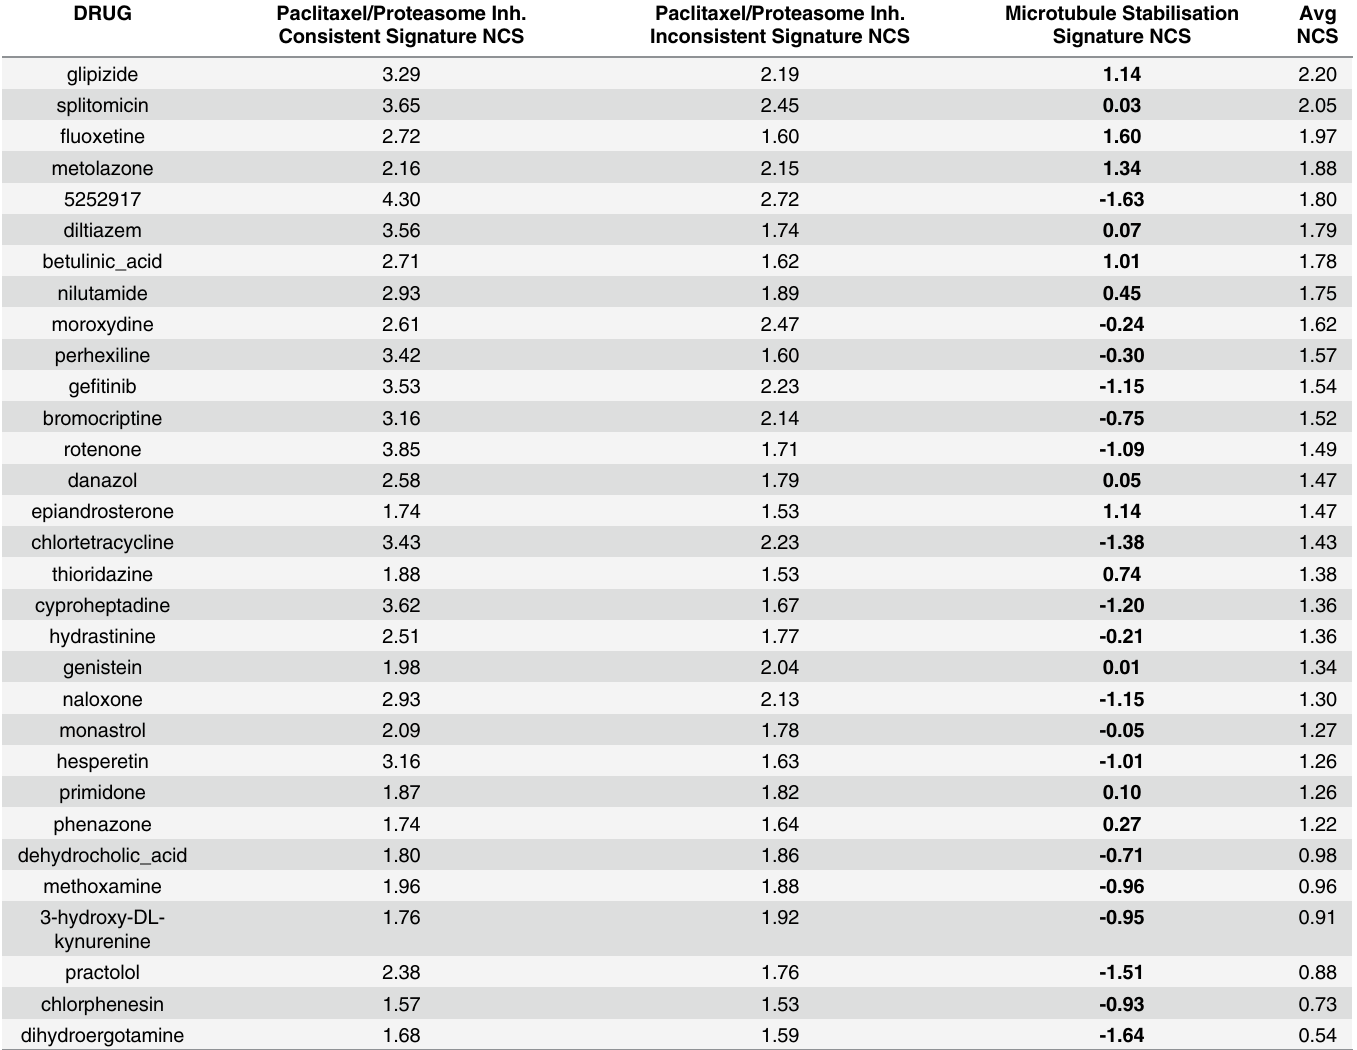
Table 1. Paclitaxel final